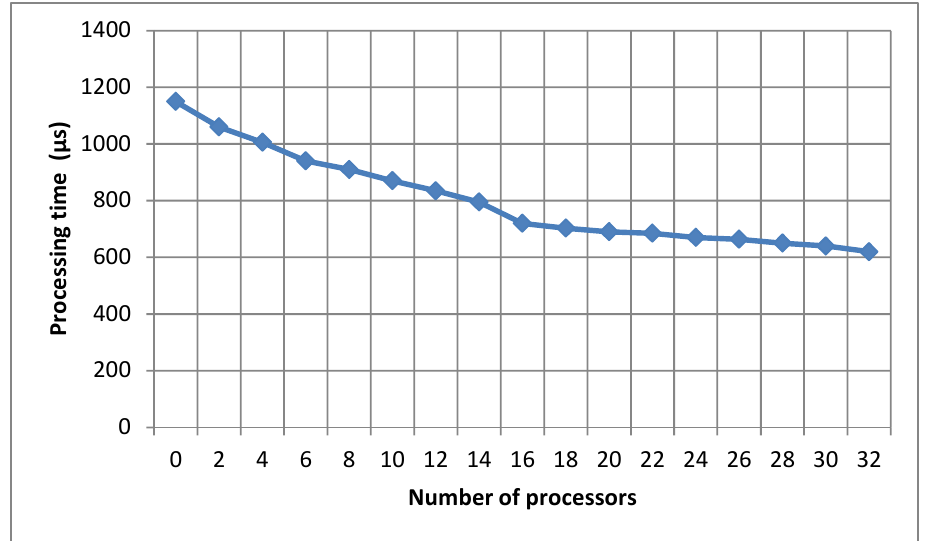
Figure 6. Dependence of SVD processing time on the number of computing processors. Table 2. Dependence of processing time on the size of the array of calculated data Matrix Dimension